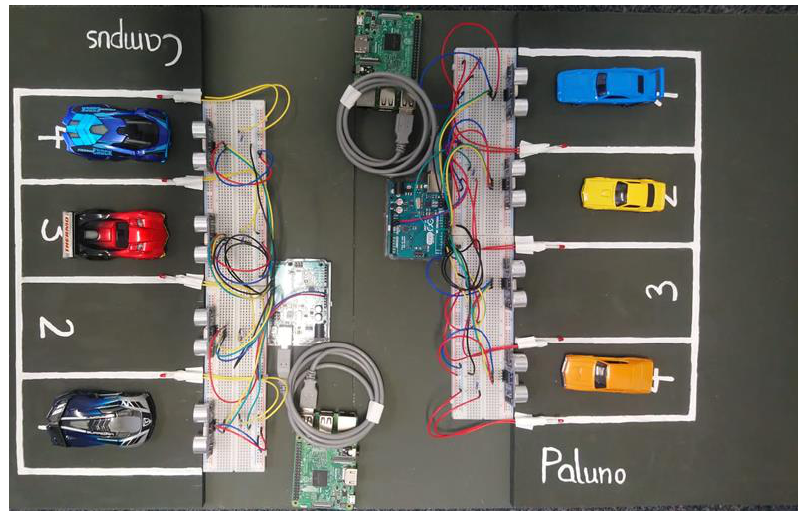
Figure 5. Functional Prototype of Smart Car Parking System.